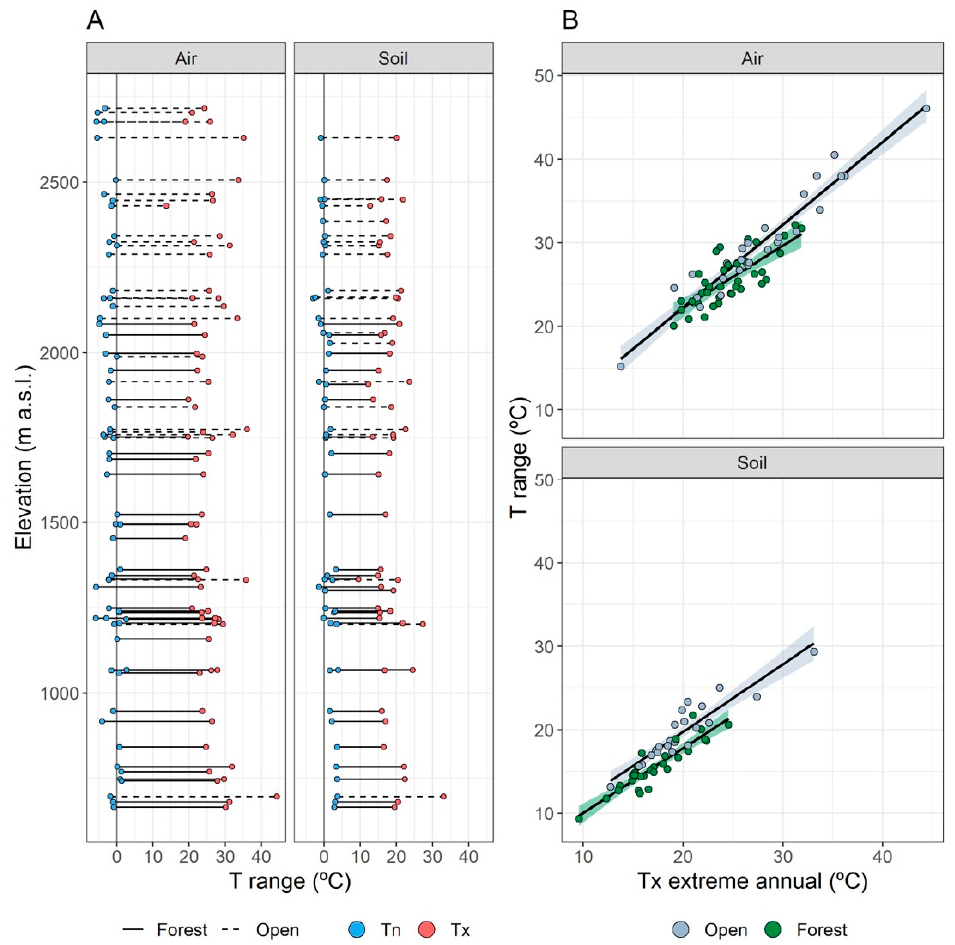
Figure 9. ( A ): Thermal range in air and soil (stability: Tx of the warmest month, Tn of the coldest one) of monitored sites in the PNOMP across the elevation gradient of 2100 m. ( B ): Association between Tx of the warmest month and the thermal amplitude for open and forested habitats, for the air and soil.